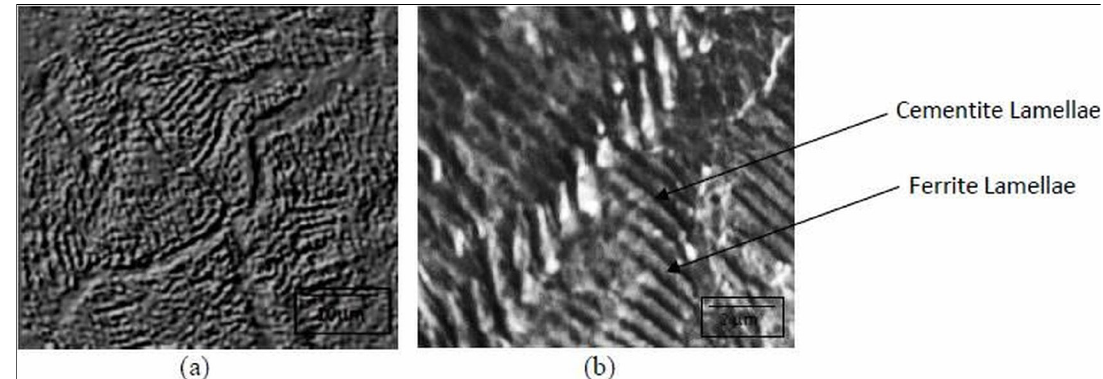
Figure 3. Microstructure of the prestressing steel wire specimen.